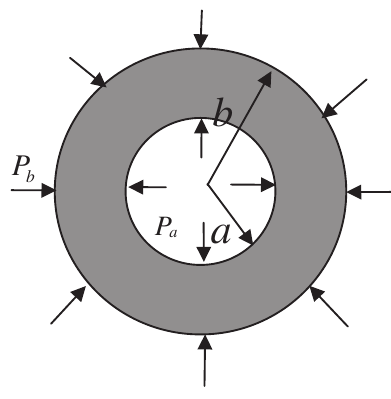
Figure 1 Model of the